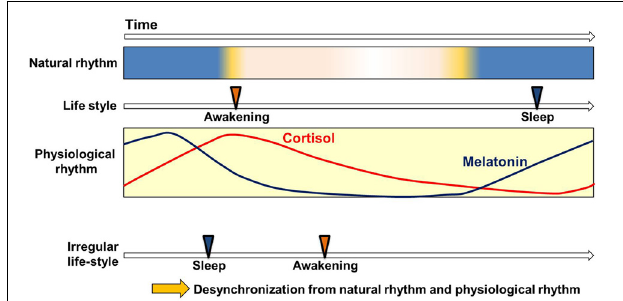
FIGURE 1 | Circadian clock and life style. Circadian variation of physiological functions is set to synchronize with the natural environment. This enables the smooth operation of physiological functions in harmony with the basic rhythms (Weitzman et al., 1971; Lewy and Markey, 1978; Arendt, 2005; Haus, 2007; Benloucif et al., 2008) and cycles of nature (light-dark) and with the correlated but not always continuous rhythms and cycles of human life-style (waking-sleep). Irregular life-styles bring about the desynchronization of physiological rhythms from other sources of